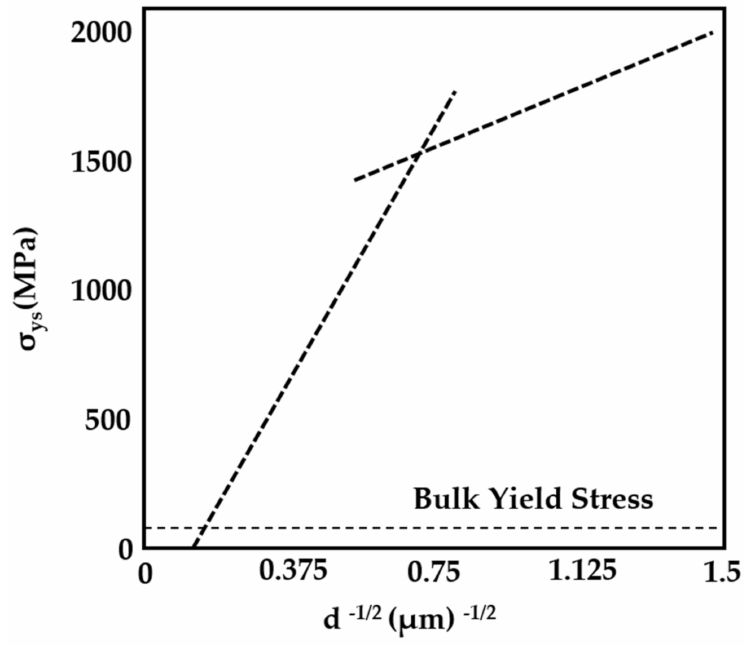
Figure 12. The relationship between the yield strength of Ni 3 A1-Ta and d − 1/2